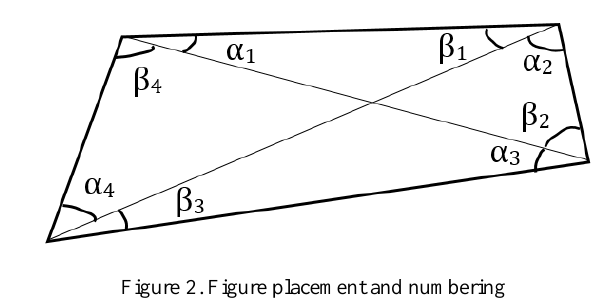
Figure 2. Figure placement and numbering Sum of quadrilateral